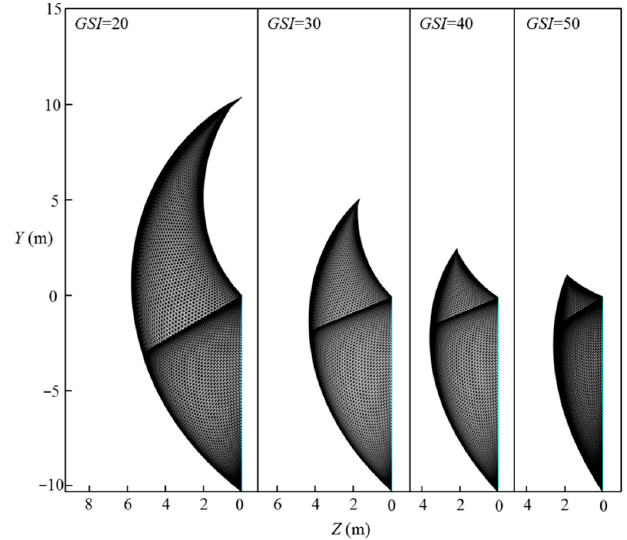
Figure 8. Effect of GSI on the normalized limit support pressure, σ T / γ H.